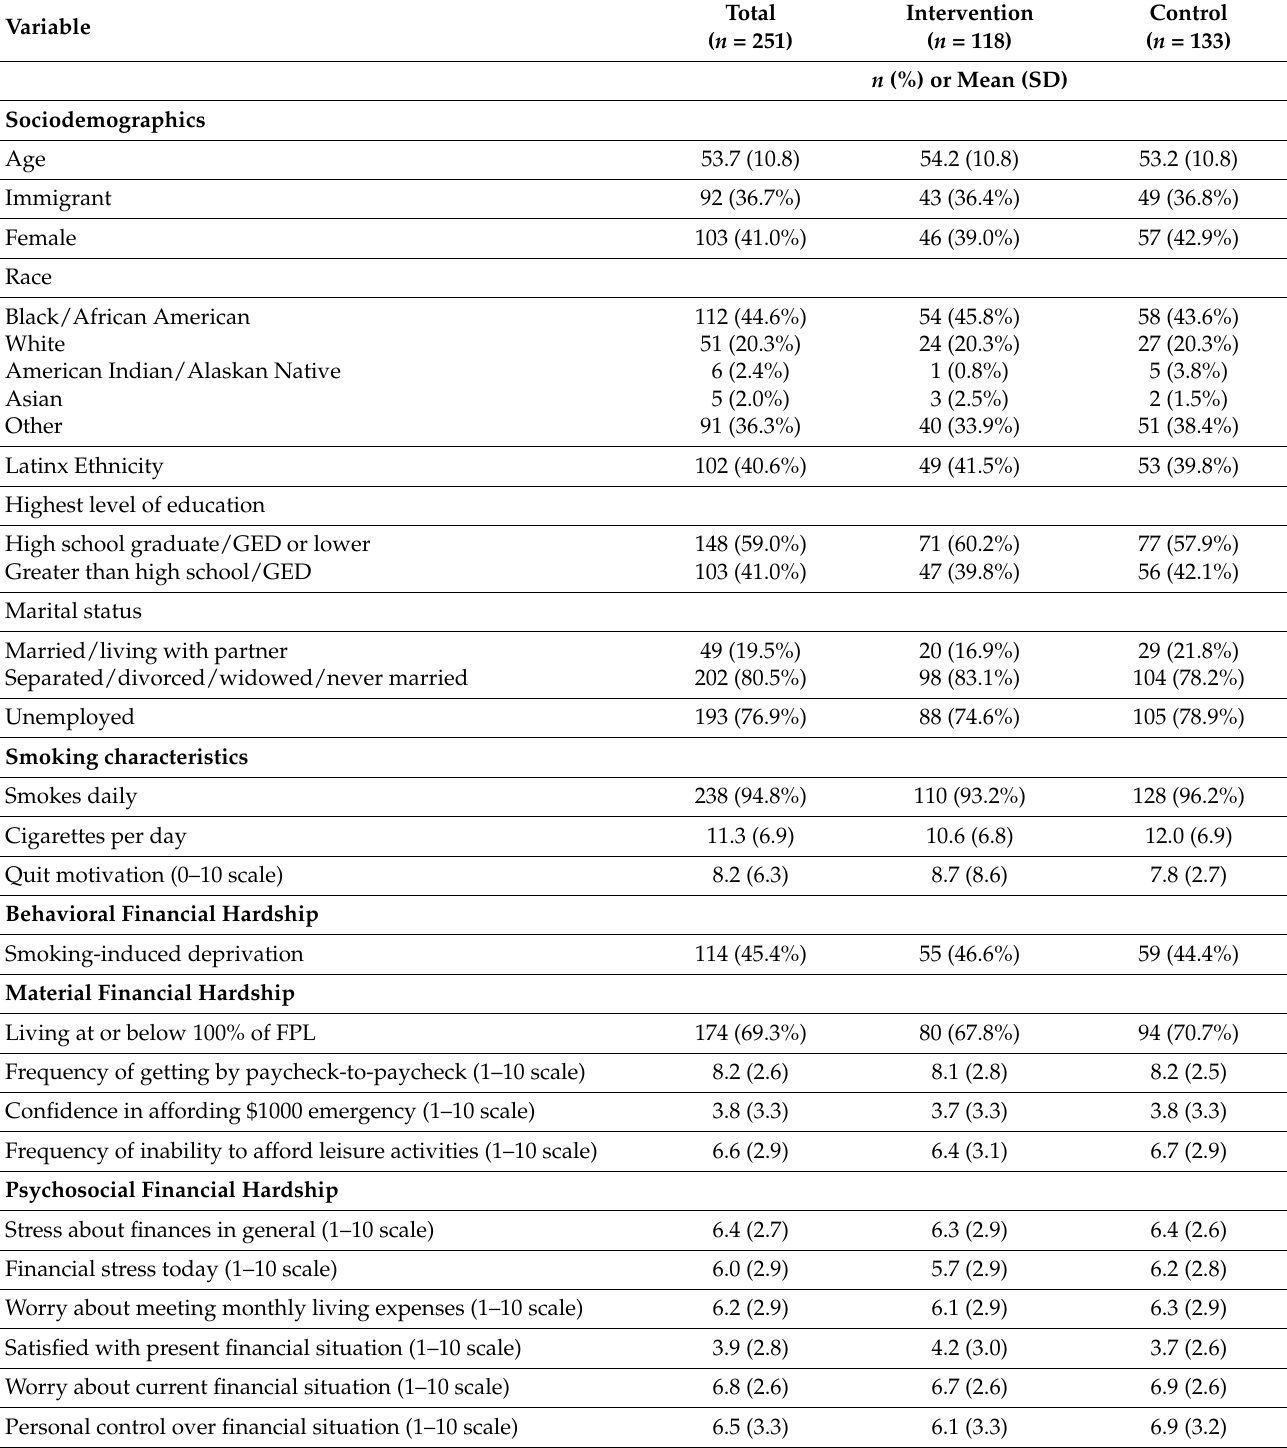
Table 1. Baseline characteristics of study